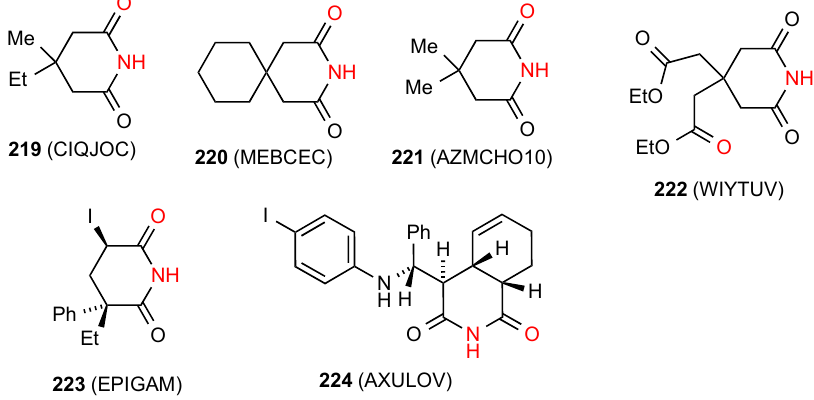
Figure 67. 4,4-Disubstituted and trisubstituted glutarimides of patterns A , B and D.